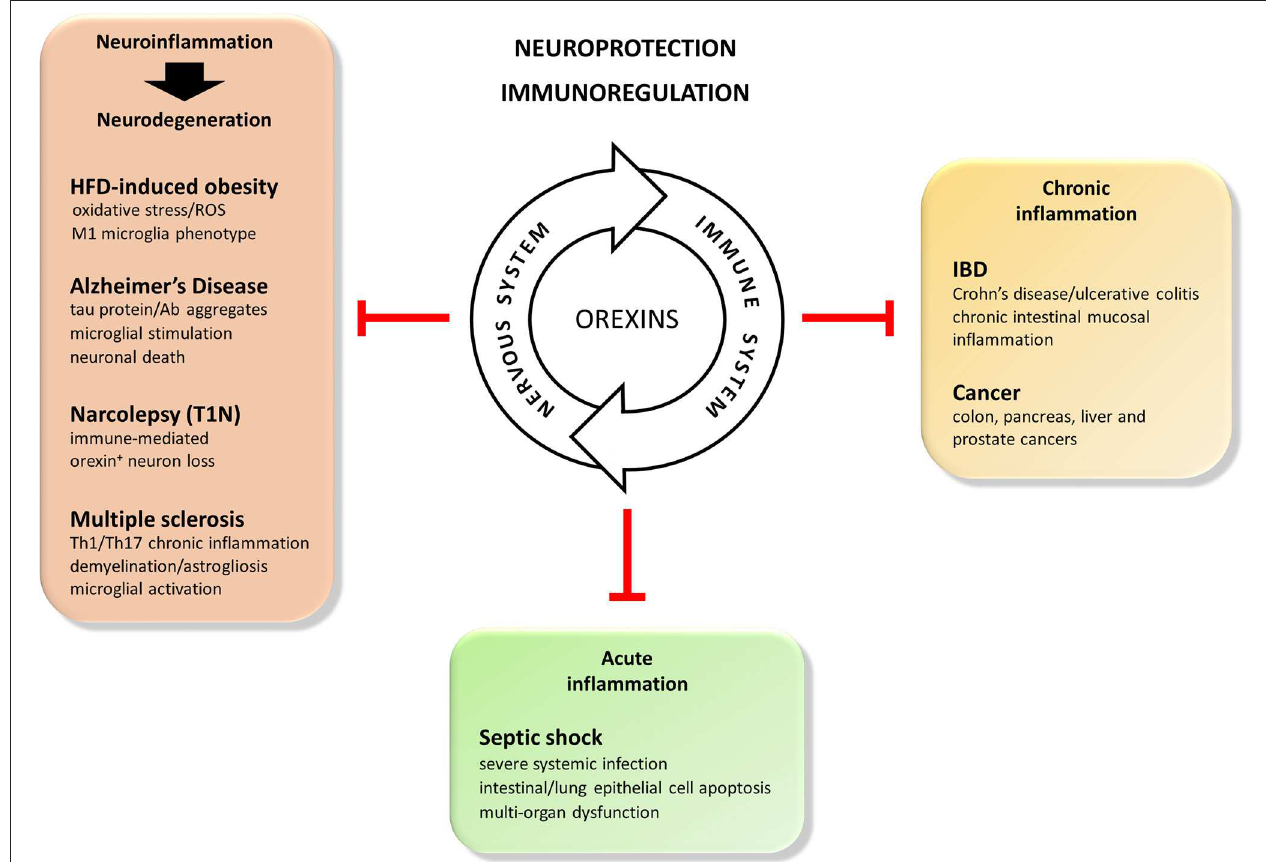
FIGURE 3 | Beneficial actions of the orexins in immune mediated disorders. Orexin neuropeptides are known to efficiently regulate sleep and arousal states, appetite and feeding, gastrointestinal motility, metabolism, cognitive processes. More recently, considering the synergic and dynamic cross-talk between the nervous and immune systems, they also display potent neuroprotective and immunoregulatory features. Therefore, the orexin/receptors system may be consider as a potential therapeutical tool for the treatment of: (1) acute inflammatory-induced diseases such as septic shock, (2) chronic inflammatory inflammatory-induced diseases such as inflammatory bowl diseases (IBD) or cancer, and (3) immune-mediated neurodegenerative diseases of the central nervous system such as high fat diet (HFD)-induced obesity, Alzheimer’s disease, narcolepsy (T1N), or multiple